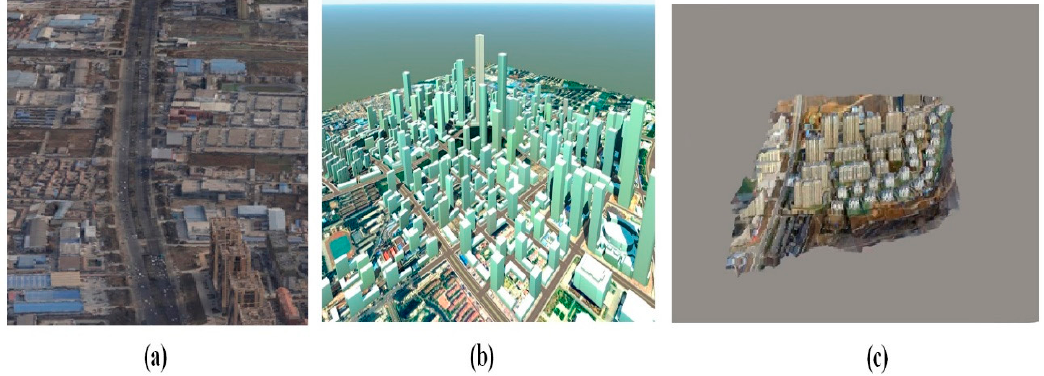
Figure 11. ( a ) Part of aerial photograph of the project area; ( b ) 3D model of the buildings in SketchUp; ( c ) 3D model of buildings in geographic information system (GIS).